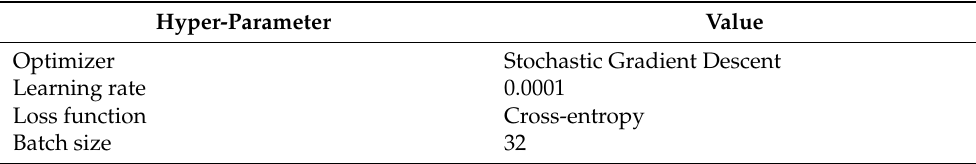
Figure 7. The architecture of the fine-tuned DenseNet 169 for the single image-based model. Table 3. The hyper-parameters of DenseNet 169 architecture.